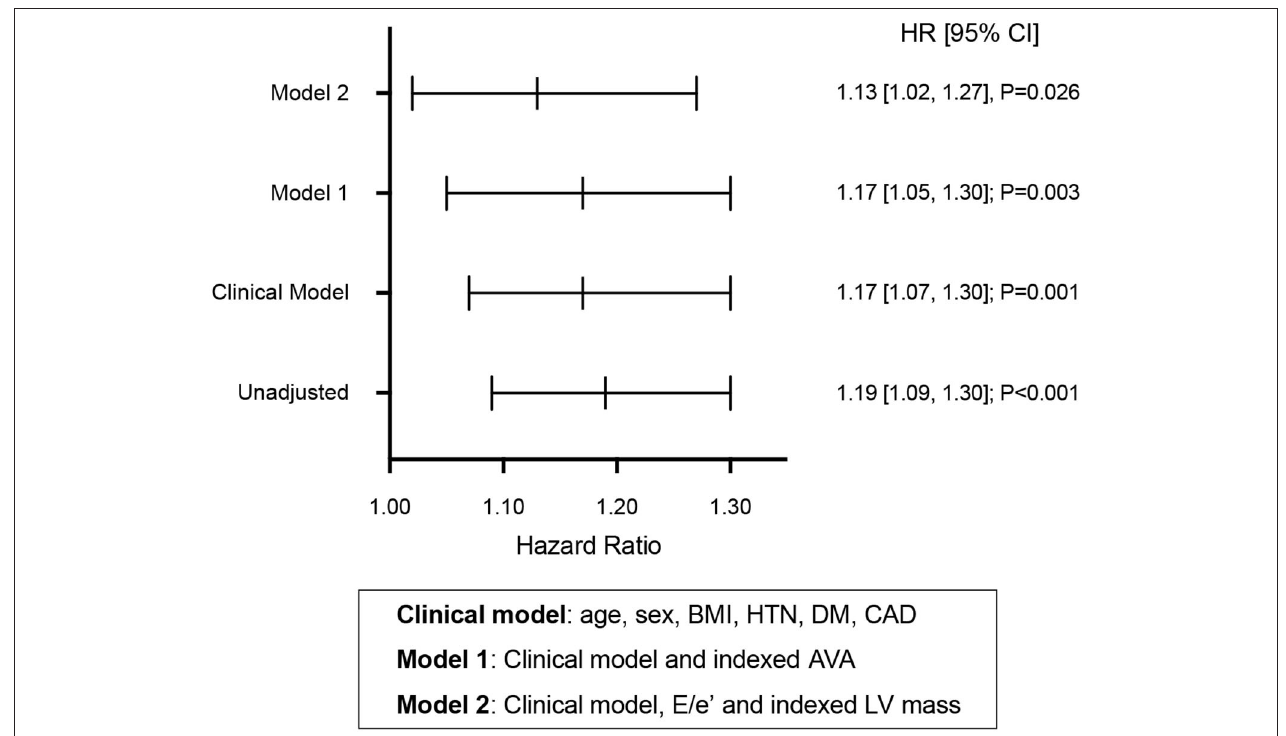
FIGURE 3 | Prognostic value of global longitudinal strain in aortic stenosis. Hazard ratios (HR) predicting time to adverse cardiovascular events for global longitudinal strain in unadjusted and adjusted cox models. BMI, body mass index; HTN, history of hypertension; DM, history of diabetes mellitus; CAD, history of coronary artery disease; AVA, aortic valve area; LV, left